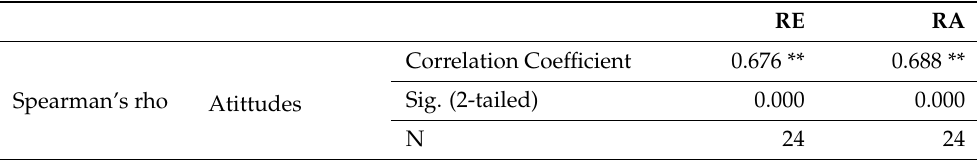
Table 16. Correlations.